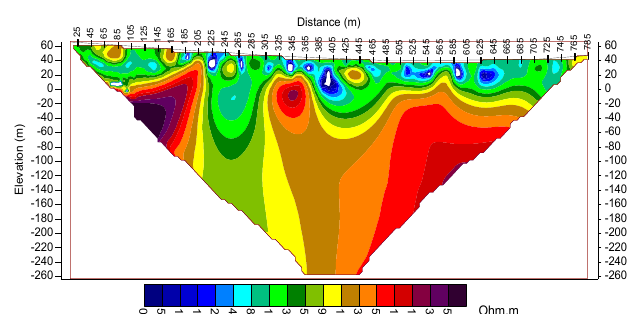
Figure 12. Resistivity section of line R2